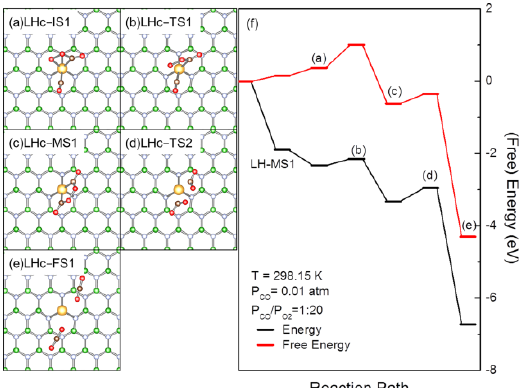
Figure 4. Optimized structures of the reaction species involved, including reaction intermediates, transition states and products ( a ) – ( e ), and (free) energy profiles ( f ) for CO oxidation over AuBN, with the LHc pathway initiated with the coadsorption of CO with LH-MS1. In ( a ) – ( e ), the B, N, C and Au atoms are in green, light blue, brown and gold, respectively. In ( f ), the bracketed letters correspond to the structures shown in ( a ) – ( e ).